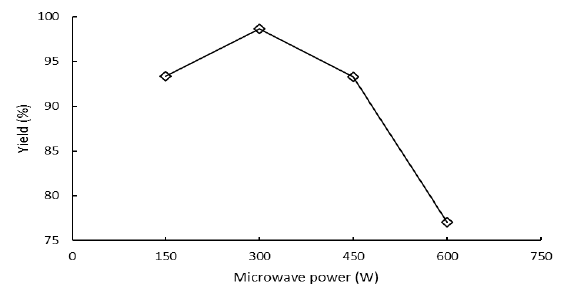
Figure 3: The effect of microwave power to yield of biodiesel (catalyst concentration at 4% and transesterification time for 15 min).